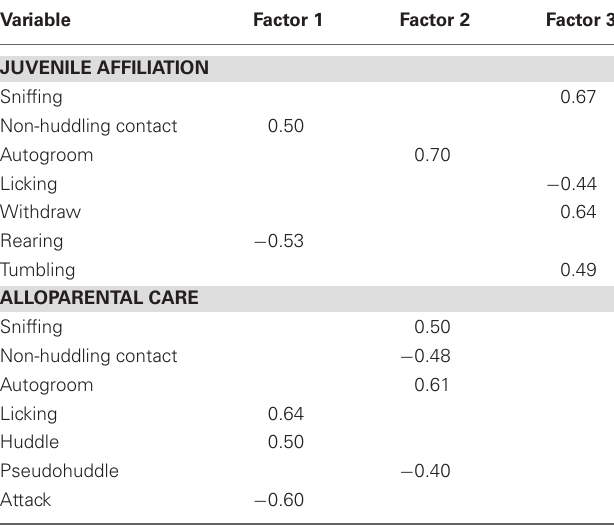
Table 5 | Factor loadings for extracted social behavior